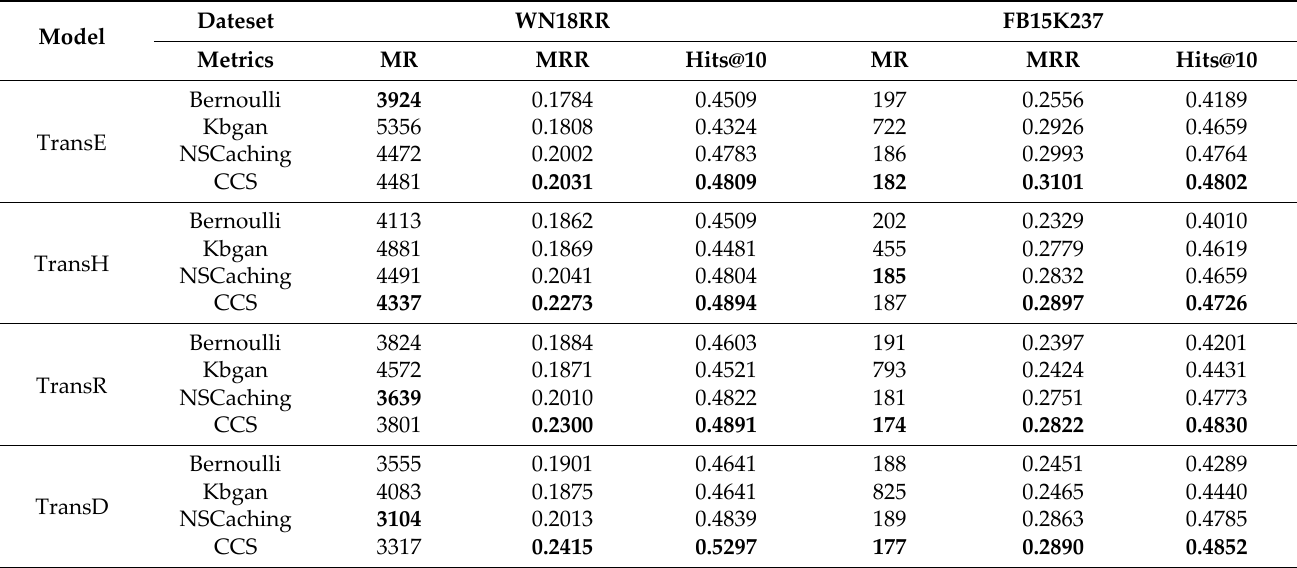
Table 5. Comparison of various negative sampling methods on two datasets, WN18RR and FB15K237. Bold indicates the best performance.